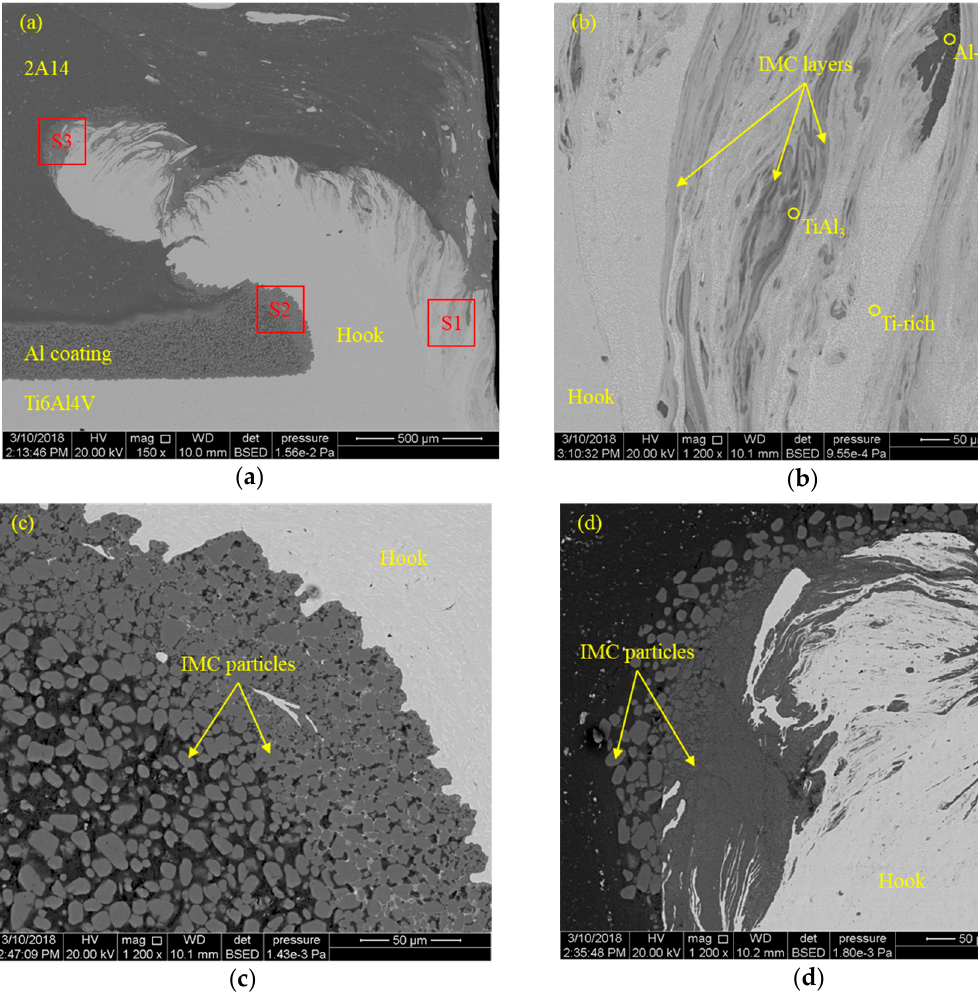
Figure 3. Typical cross-sectional of the FSSW-B joint made at the rotation speed of 1200 rpm. The labeled dimensions were measured via the optical microscope measurement.